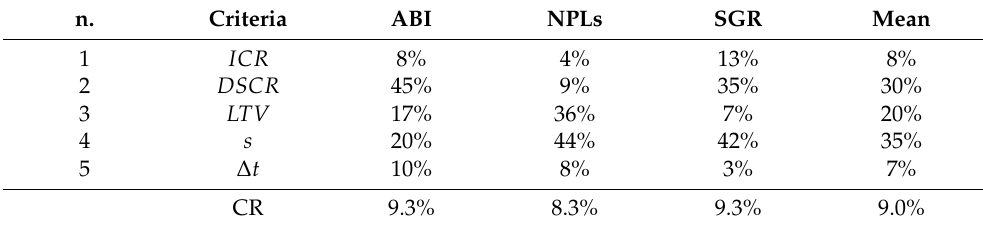
Table 4. Weights of the criteria.